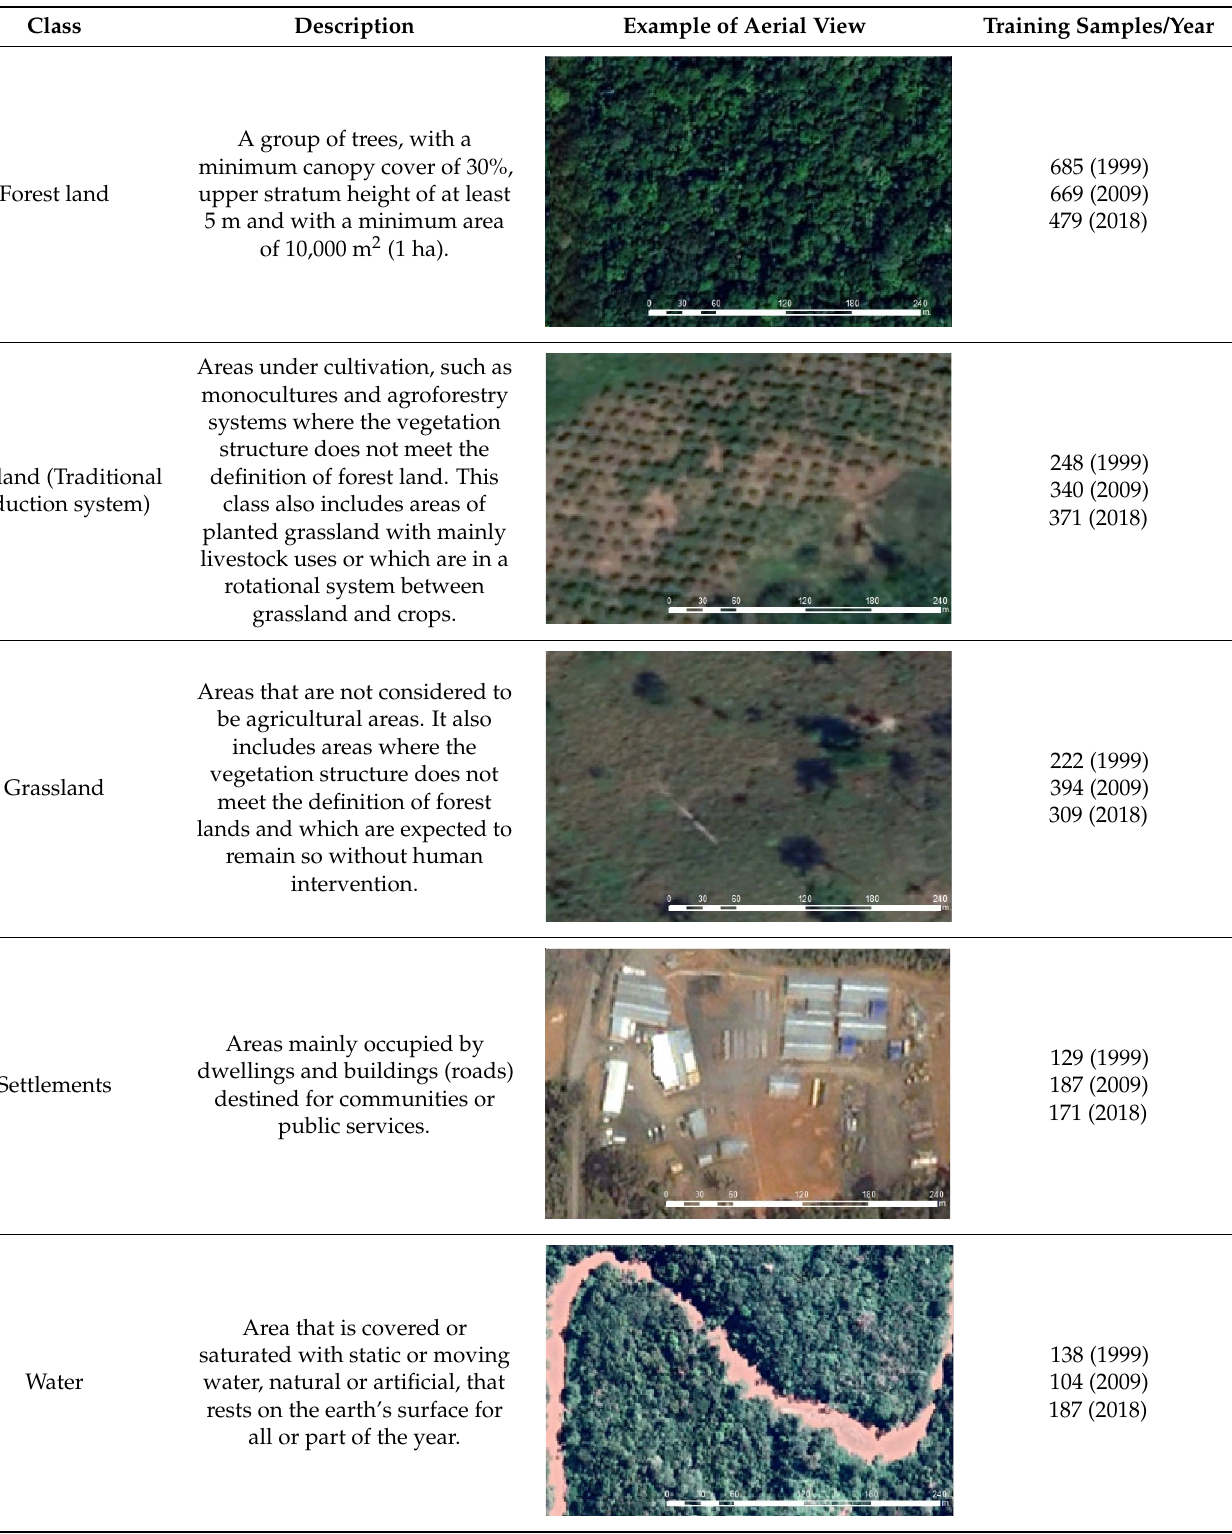
Table 2. Land use and land cover (LULC) classification scheme.